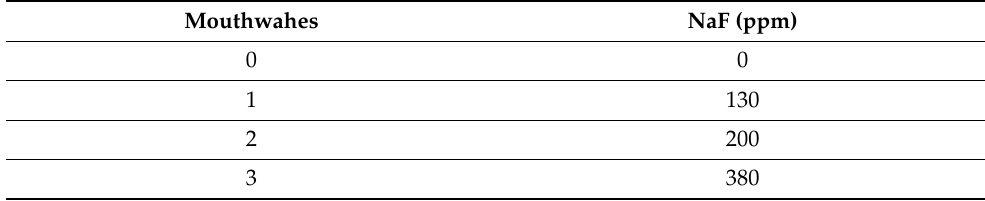
Table 1. NaF composition of the different